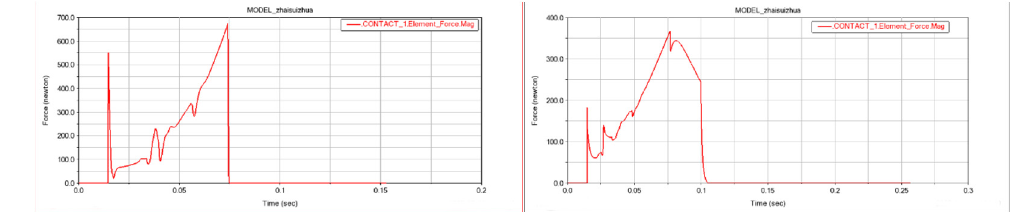
Figure 6. Contact force on the ear when the forward speed is 0.29 m/s, and the claw picking claw speed is 2 m/s.